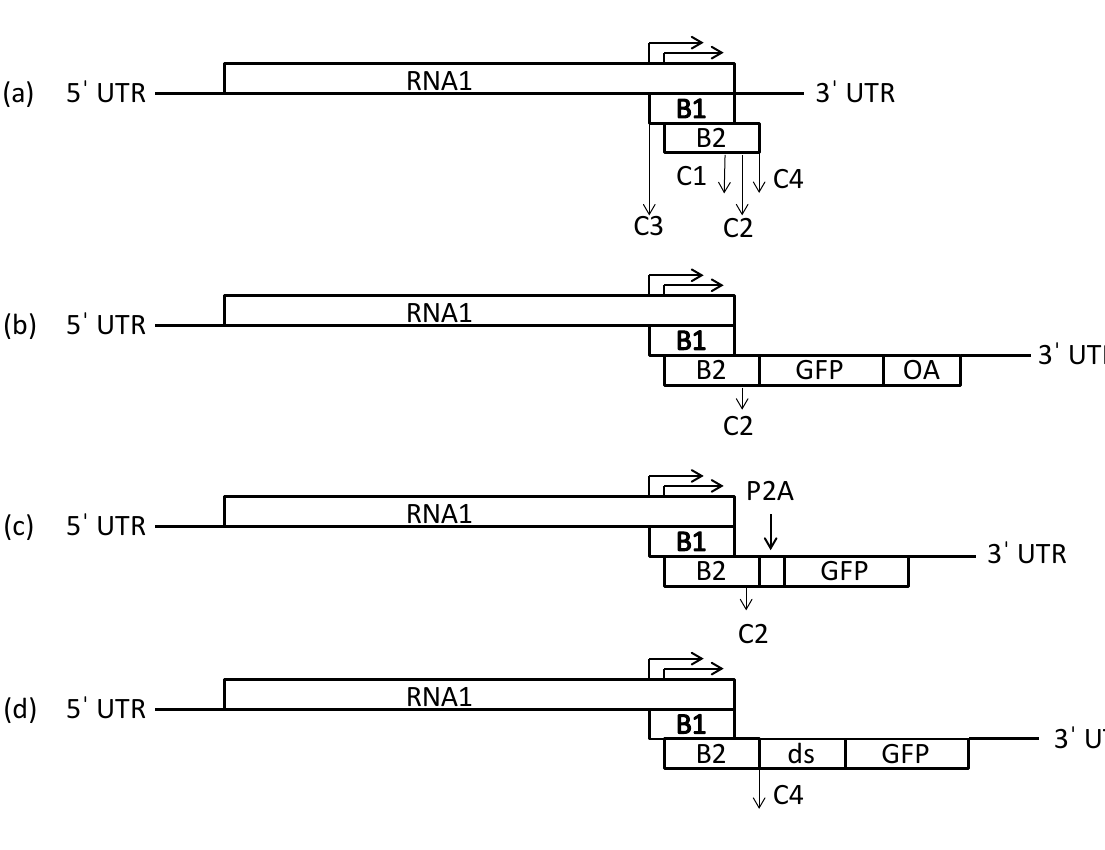
Figure 1. Schematic representation of the Flock House virus RNA1 vector constructs. ( a ) FHV RNA1 genome with subgenomic proteins, B1 and B2. Arrow positions correspond to insertion sites that were engineered into the FHV RNA1 clone: C1- 3034 bp, C2- 3037 bp, C3- 2731 bp, C4- 3055 bp; ( b ) FHV-C2-GFP-P2A; ( c ) FHV-C4-GFP-ds where ds1